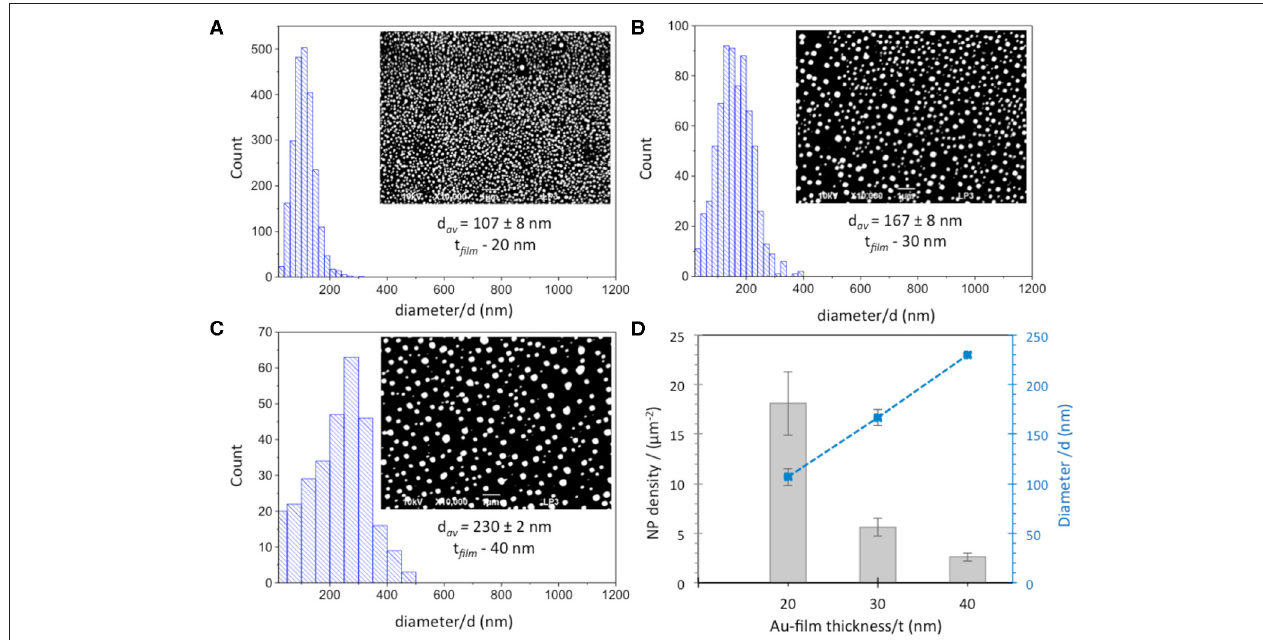
FIGURE 1 | Size distribution and SEM images (inset) of AuNPs obtained from (A) 20nm, (B) 30nm and (C) 40nm Au film thicknesses. Scale bar is 1 µ m. (D) Dependence of diameter (blue squares) and density (gray columns) of AuNPs obtained after laser irradiation of Au-films on Au film